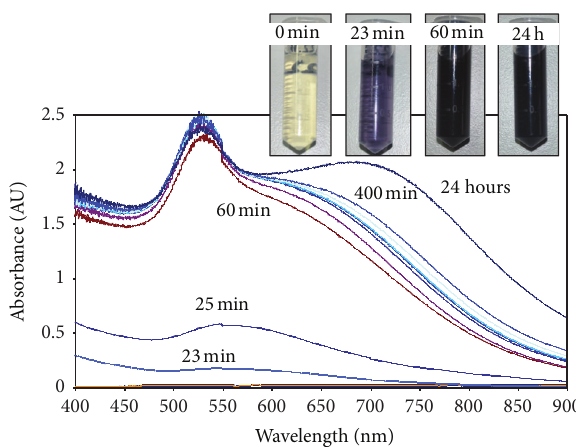
Figure 6: Gold-dendrimers Au-G6-2.5 formation and evolution over 24 hours as recorded by UV-VIS measurements; absorbance was recorded at moment 0, 23 minutes, 25 minutes, 60 minutes, 120 minutes, 205 minutes, 235 minutes, 252 minutes, 300 minutes, 400 minutes, and 24 hours after synthesis,